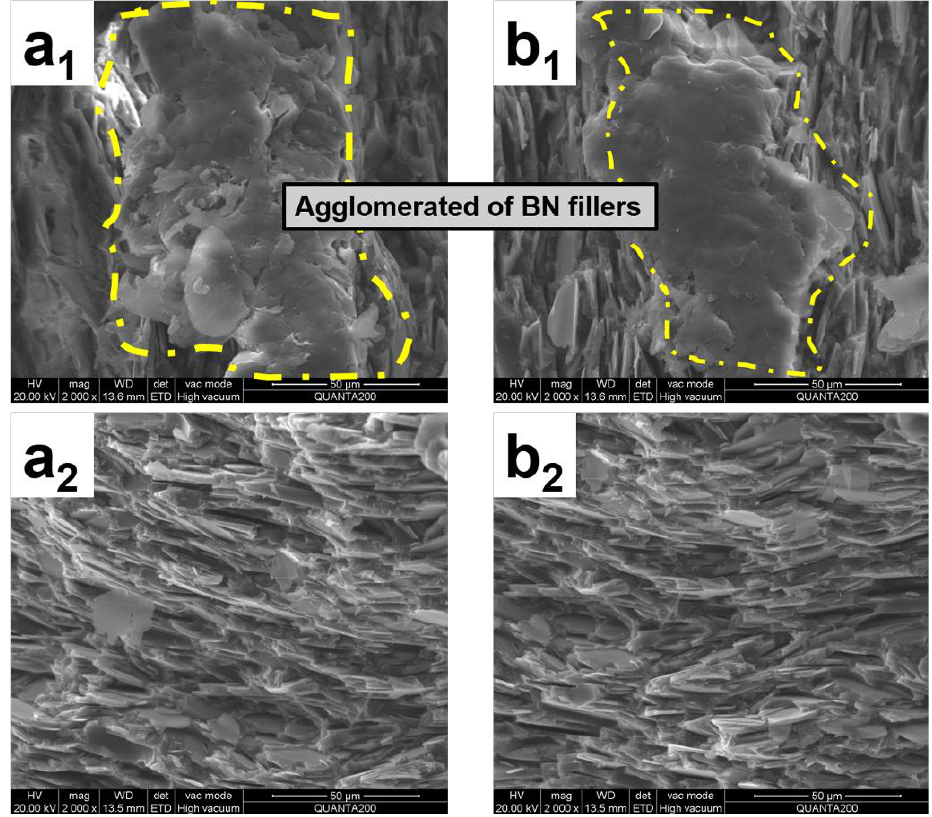
Figure 4. SEM images of BN/PPS (60/40) ( a 1 ), BN/PPS/Si-DF (60/35/5) ( a 2 ), BN/PPS (70/30) ( b 1 ) and BN/PPS/Si-DF (70/25/5) ( b 2 ).